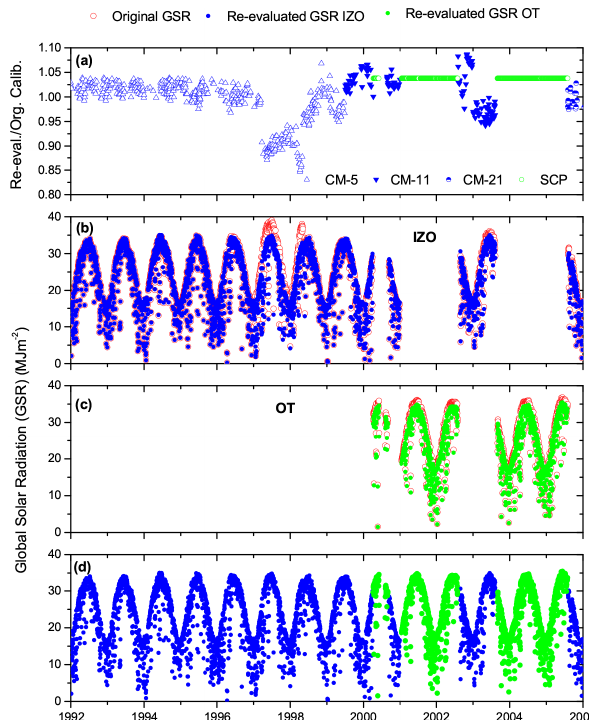
Figure 2. (a) Evolution of the ratio between the re-evaluated cal- ibration and the original calibration for the different pyranometers installed at IZO (blue squares) and at OT (green squares). (b) , (c) and (d) : time series of the GSR (MJm − 2 ) from 1992 to 2005 at IZO, at OT and the whole recalibrated time series, respectively (red squares represent original GSR, blue squares represent re-evaluated GSR at IZO and green squares represent re-evaluated GSR at